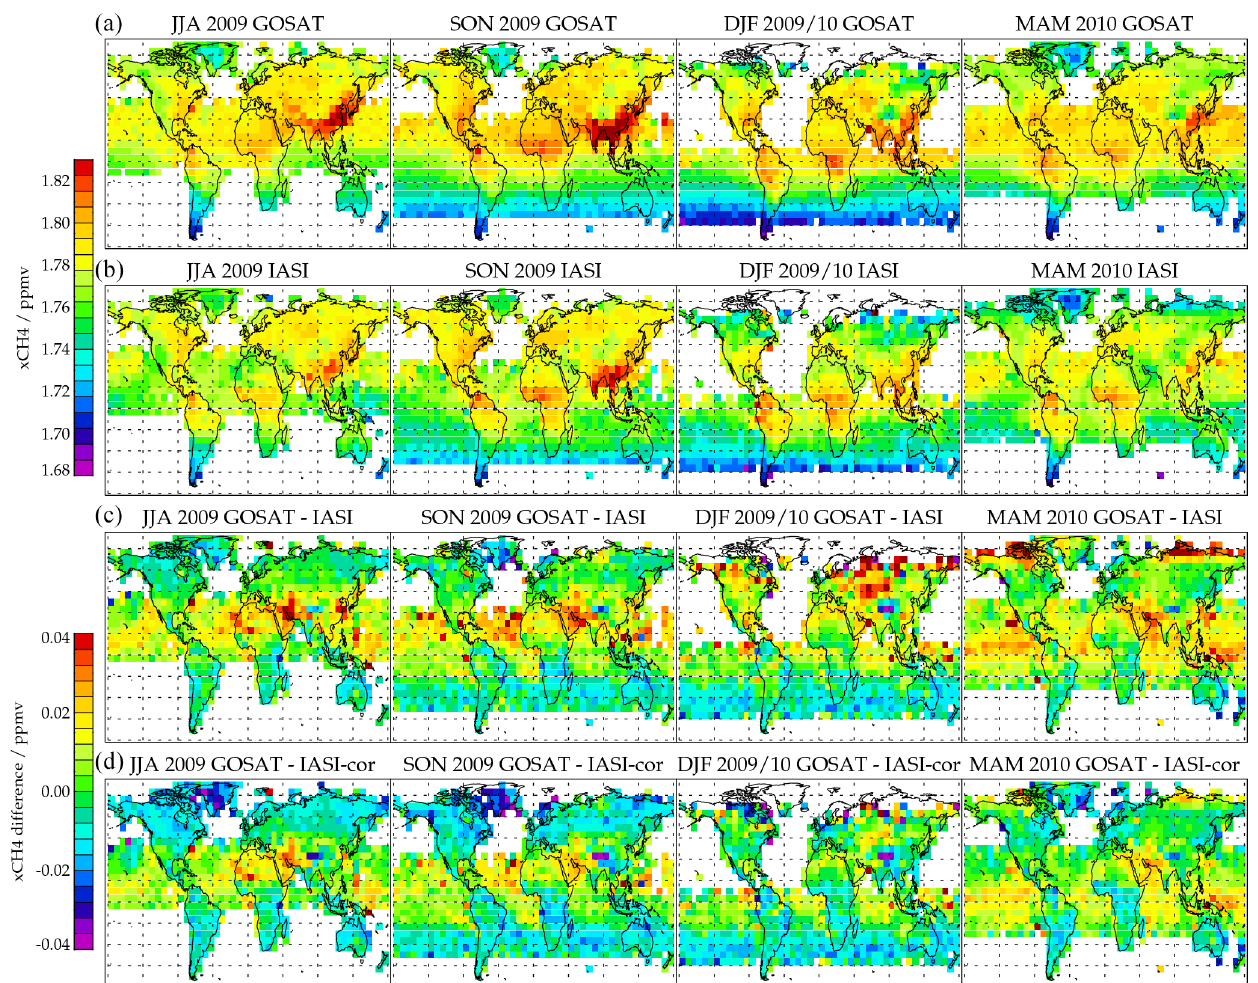
Figure 13. Seasonal mean distributions of column-averaged methane in 2009–2010 from GOSAT (a) and IASI daytime observations, sam- pled on a daily basis like GOSAT (b) . Panel (c) shows differences between the GOSAT and the IASI daytime means. Panel (d) shows differences after correcting IASI for differences in the IASI/GOSAT vertical sensitivity using